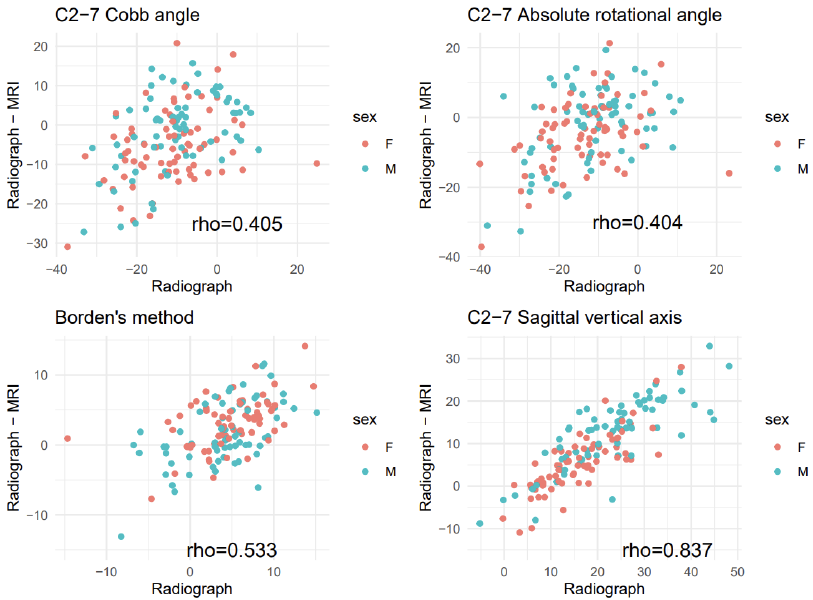
Figure 4. Scatter plots for radiographic measurements versus difference between the two paired measurements (radiographic—magnetic resonance imaging (MRI)). Rho indicates Spearman correlation coefficient (without stratification by sex).